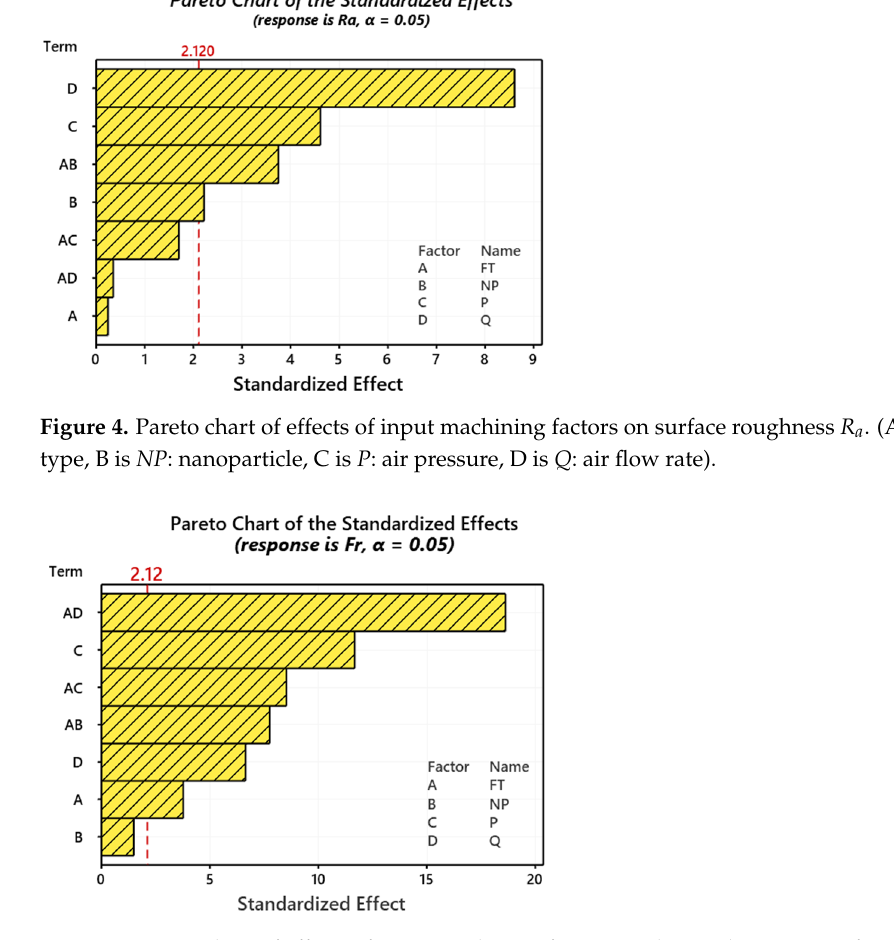
Figure 5. Pareto chart of effects of input machining factors on the resultant cutting force F r . (A is FT : Fluid type, B is NP : nanoparticle, C is P : air pressure, D is Q : air flow rate).